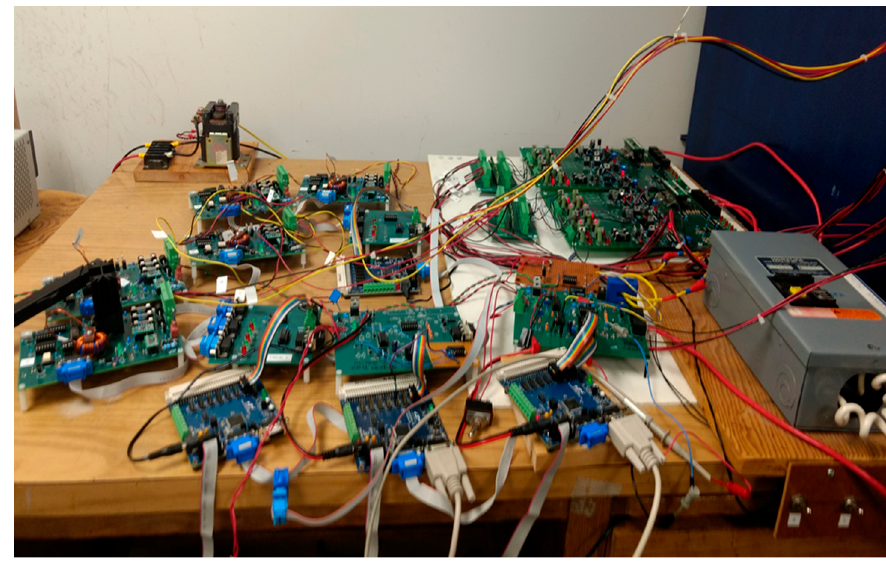
Figure 7. BEQ laboratory prototype.